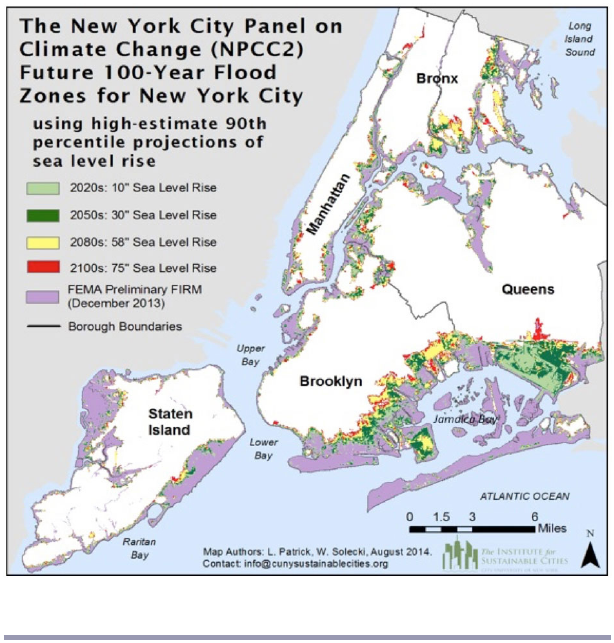
Fig. 3 . Future 1% flood extent with projected sea level rise (source: Rosenzweig and Solecki